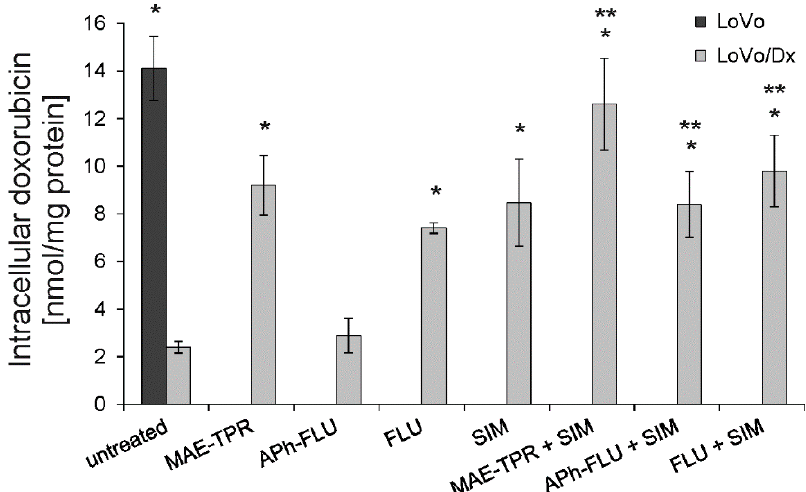
Figure 3. Intracellular doxorubicin (Dox)accumulation in LoVo (dark grey bars) and Lovo/DX cells (light grey bars) treated with phenothiazine derivatives, simvastatin (SIM) and phenothiazine derivatives in combination with simvastatin. Means of three experiments ± SD are presented. The statistically significant differences from the untreated LoVo/Dx control were determined using Student’s t -test (* p < 0.05). The statistically significant differences between the samples containing phenothiazine derivative as a single agent and samples with phenothiazine derivative combined with simvastatin were also determined using the Student’s t -test (** p < 0.05).